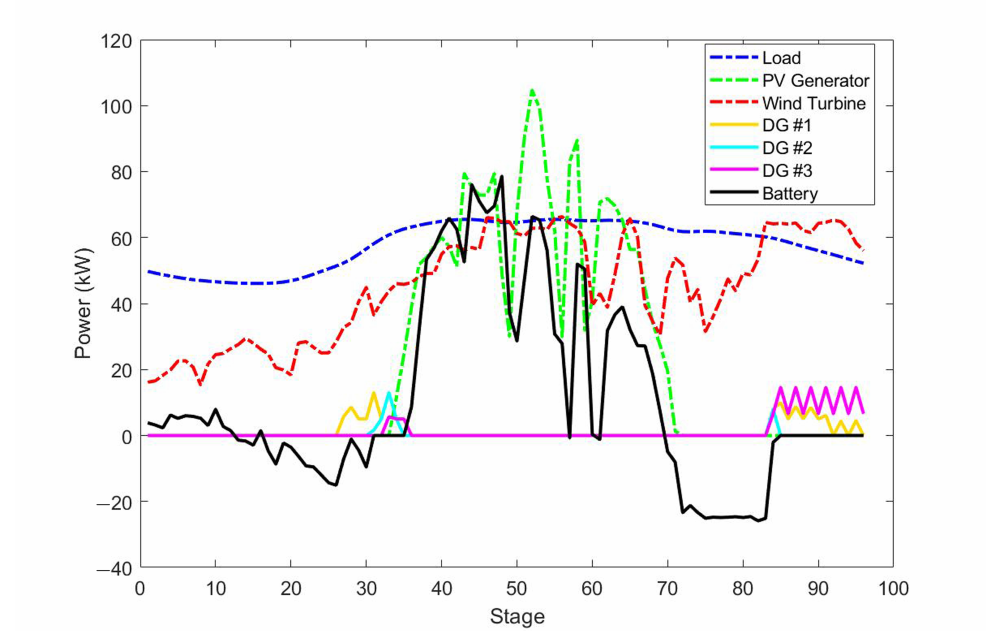
Figure 6. Actual power data of load and Renewable Energy Sources (RES) generation, and the actual operation results of diesel generator and energy storage units using our improved